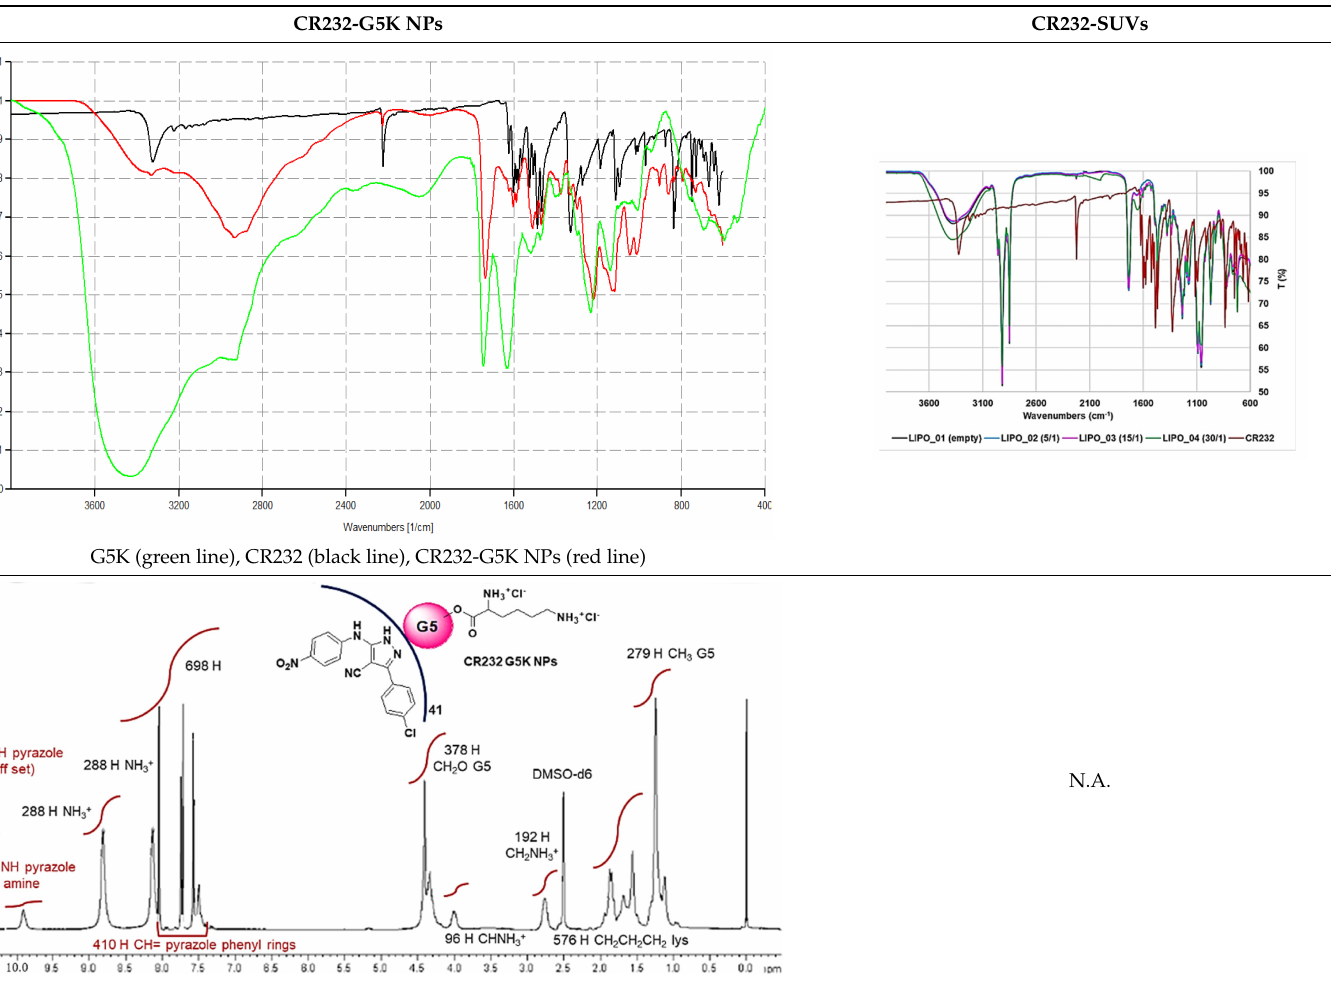
Table 8. Main Physicochemical Properties of CR232-G5K NPs and